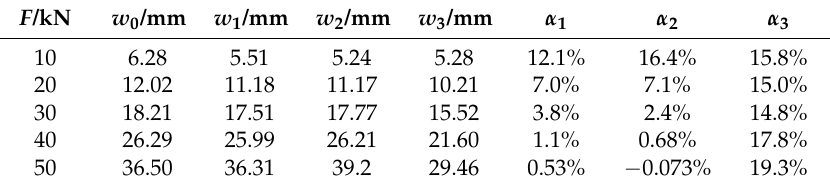
Table 3. Mid-span displacement comparison under various loads.